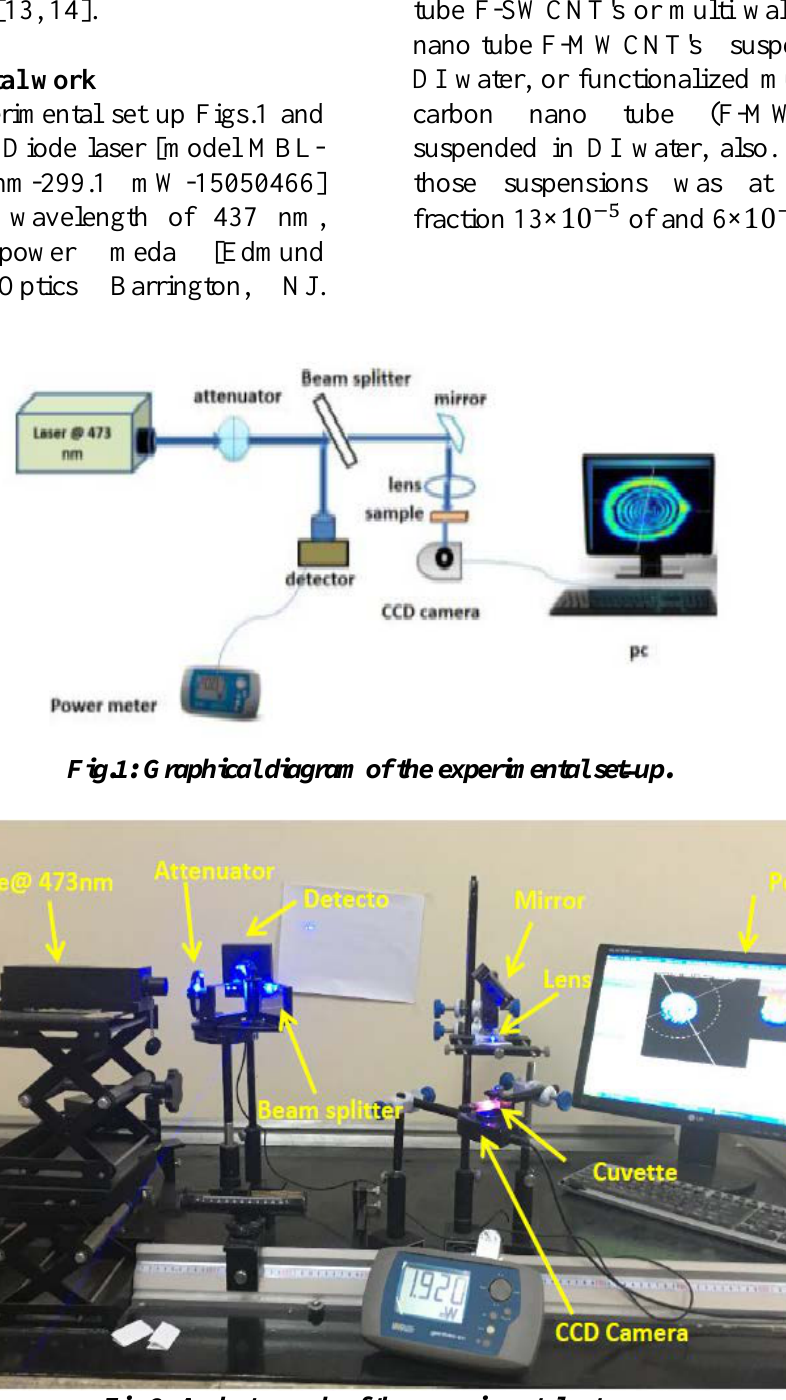
Fig.2: A photograph of the experimental